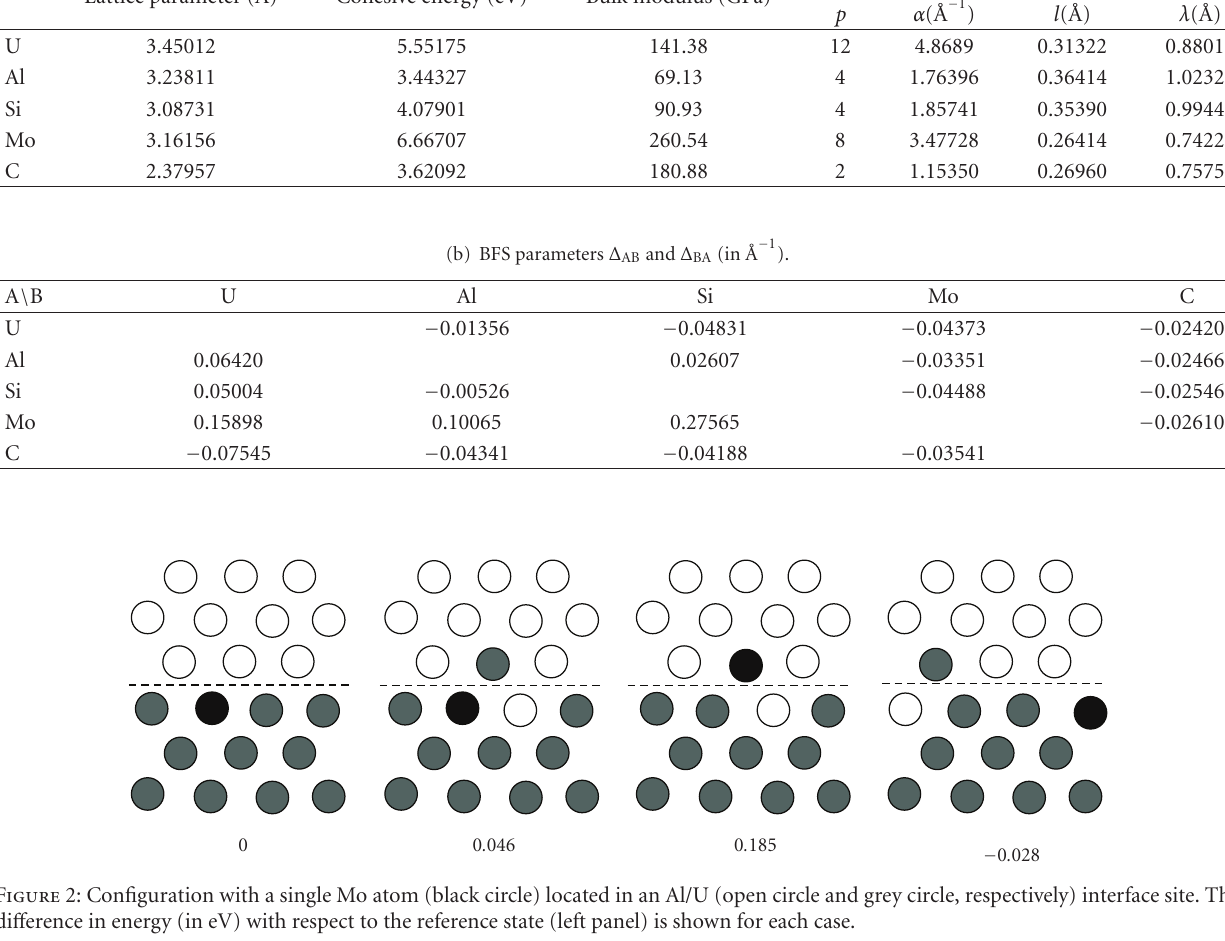
All the necessary single element parameters are listed